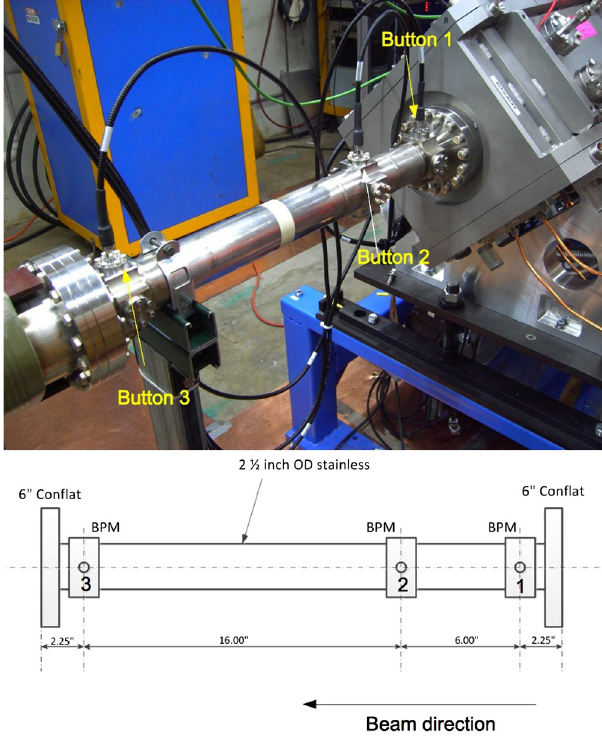
FIG. 9. The time-of-flight measurement setup consists of three button BPMs spaced unequally longitudinally on a 2 . 5 00 beam pipe. Notice the numbering on the BPMs.